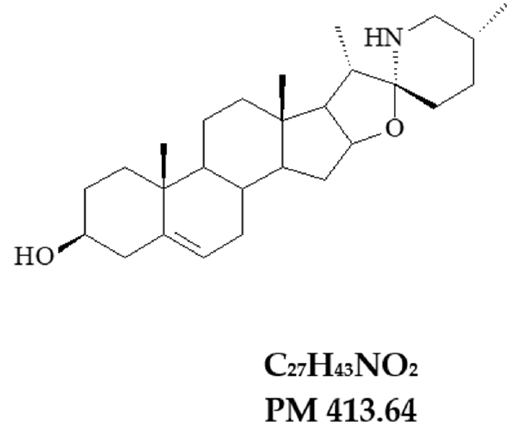
Figure 6. Solasodine. Figure 6.